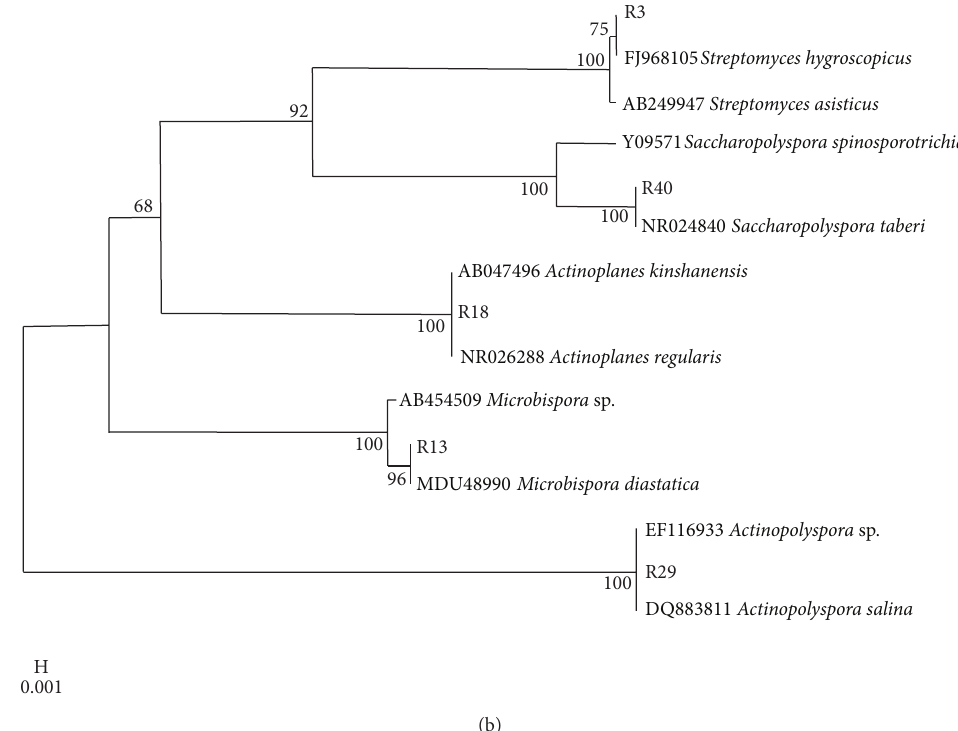
Figure 3: (a) Phylogenetic relationships among species of the genera Streptomyces (600bp); Micromonospora (1kb); Streptosporangium (500bp); Thermomonospora (800bp), and Dactylosporangium (580 bp) based on partial nucleotide sequences of the 16S rDNA. The tree was constructed using the maximum parsimony method. Percentages at nodes represent levels of bootstrap support from 1000 resampled datasets. GenBank accession numbers are given in parentheses and (b). Phylogenetic analysis of actinomycetes isolates from Sambhar salt lake based on partial nucleotide sequences (1.5kb) of the 16S rDNA. The tree was constructed using the neighbor-joining method. Percentages at nodes represent levels of bootstrap support from 1000 resampled datasets. Bootstrap values less than 50% are not shown. The bar